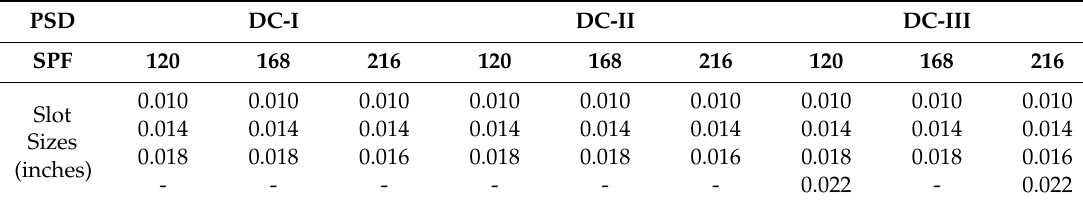
Table 2. Slot sizes of coupons for each PSD.